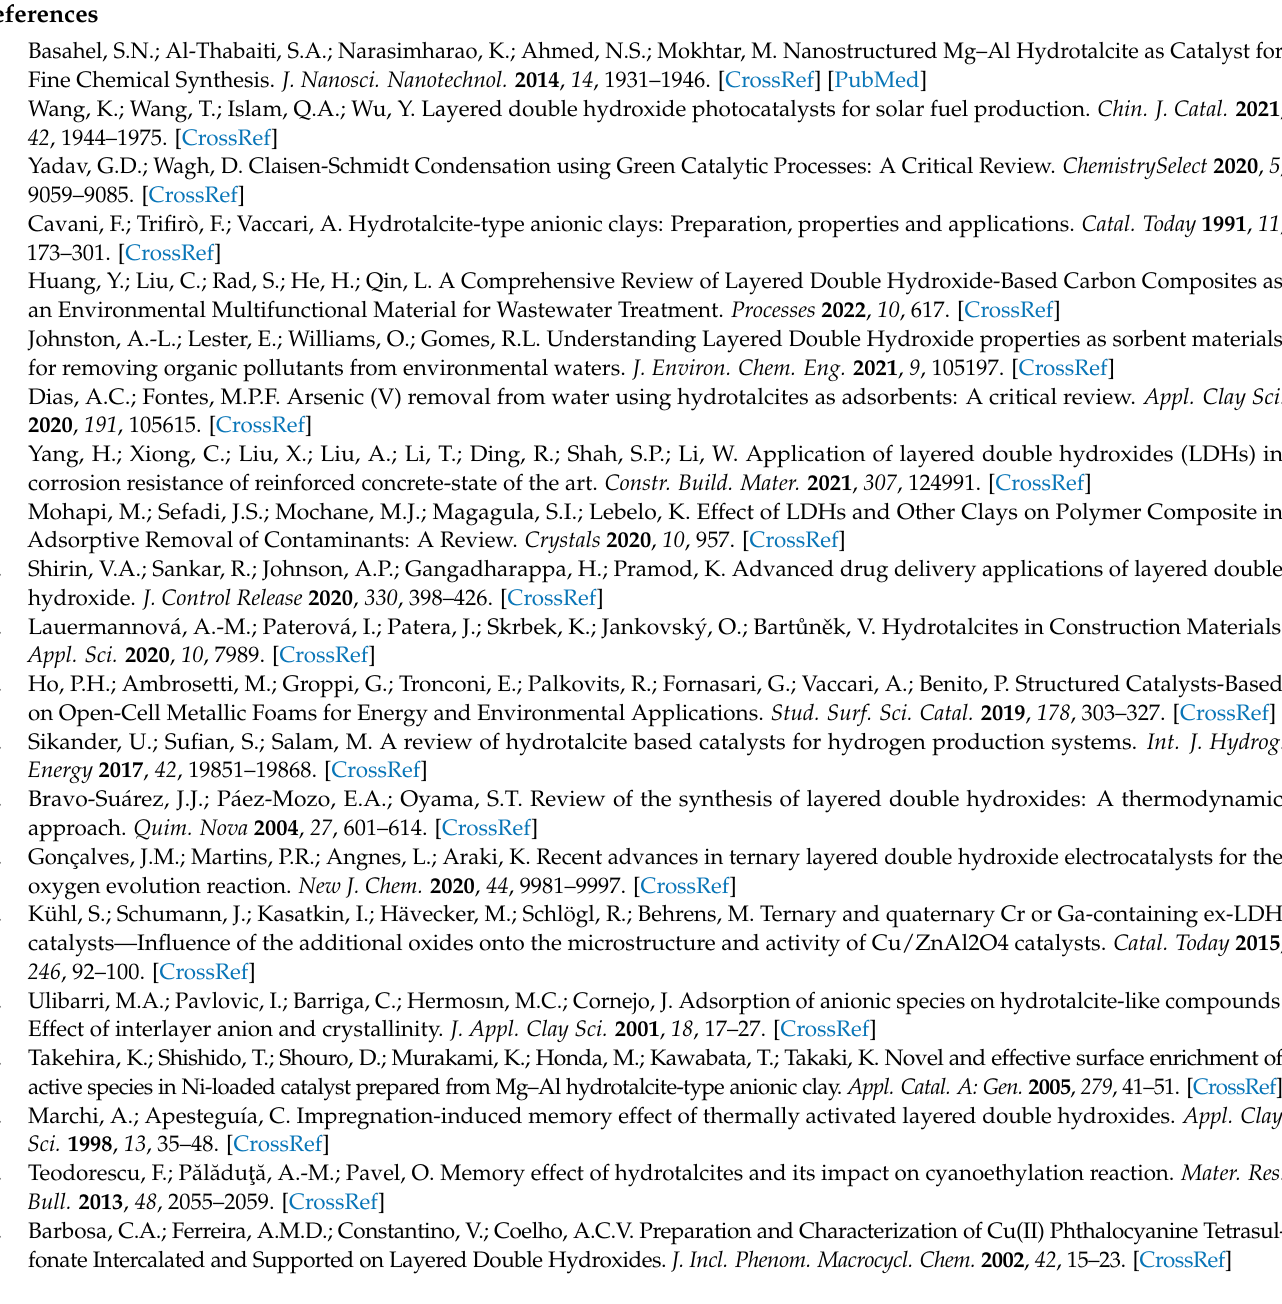
Figure S2: Isotherm linear plot of LDH